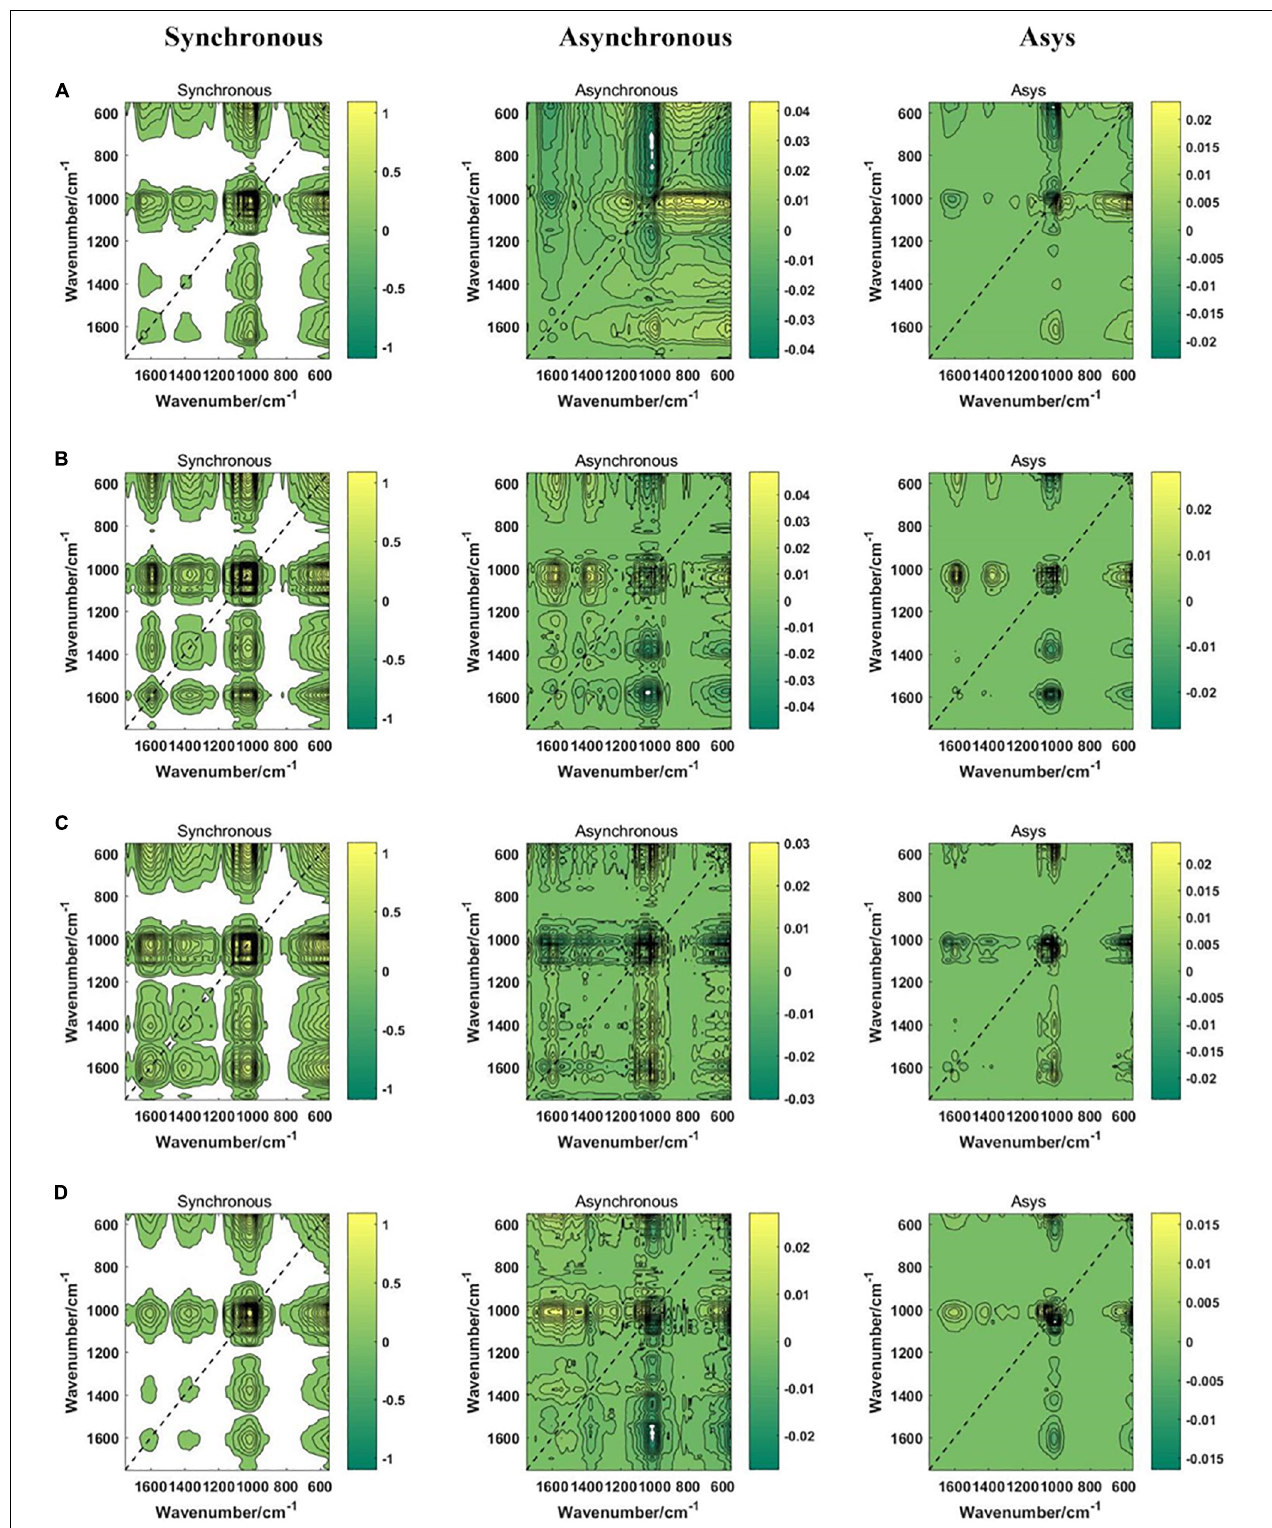
FIGURE 4 | The synchronous, asynchronous and integrated 2DCOS images of parts. (A) rhizome; (B) stem; (C) leaf; (D) fibrous root. Asys images are i2DCOS images.